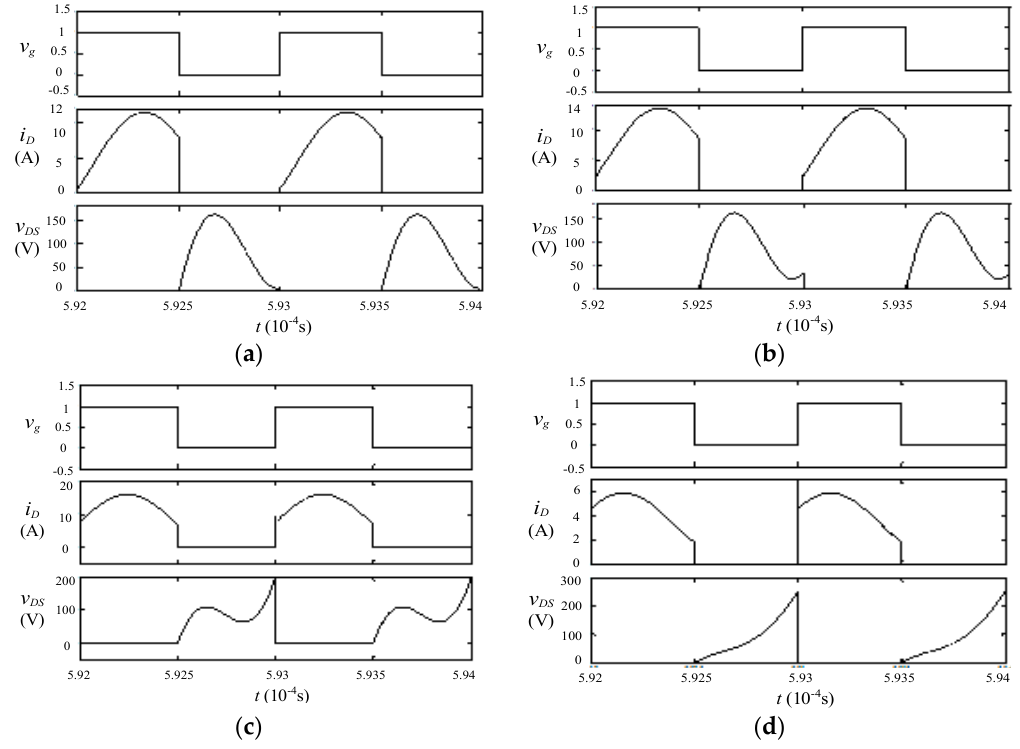
Figure 10. Switching states with various distance between the transmitter coil and iron plate. ( a ) d 2 = 20 cm; ( b ) d 2 = 15 cm; ( c ) d 2 = 10 cm; ( d ) d 2 = 5 cm.